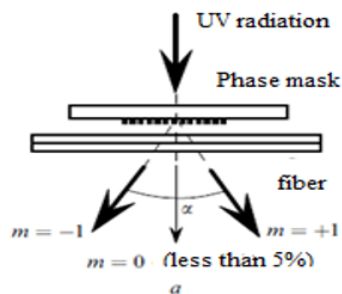
Fig. 1. Scheme of FBG recording by means of phase mask (direct recording).